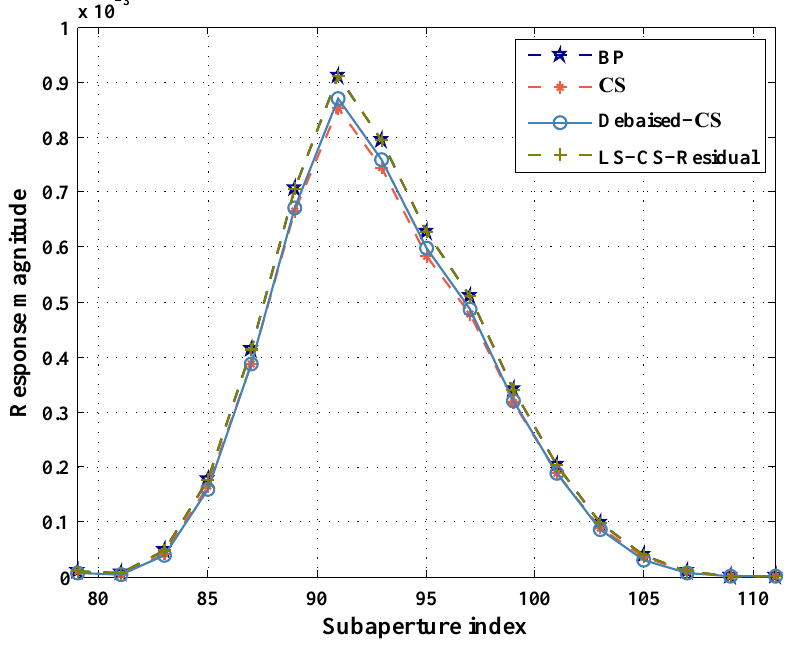
Figure 5. Reconstructed aspect dependent scattering of target via the three